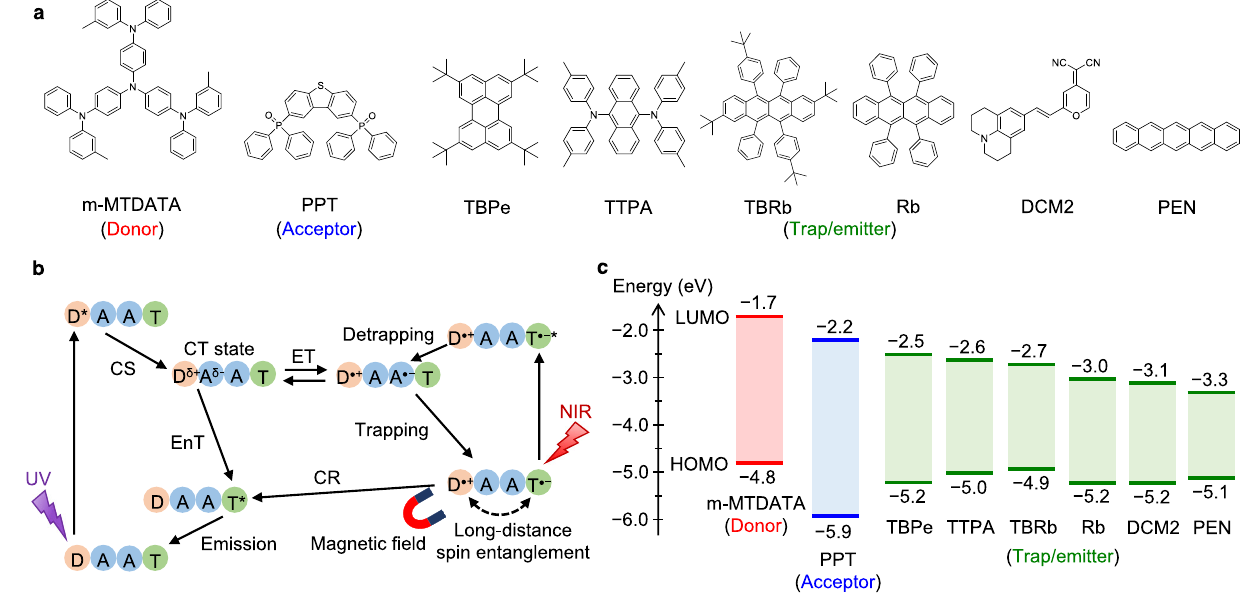
Fig. 1 Schematic illustration of organic PSL systems. a Molecular structures of m-MTDATA, PPT, and trap/emitter molecules. b Proposed reaction scheme of organic PSL. During UV excitation, an electron is transferred from the excited state of donor (D) to acceptor (A) to form the CT excited state or exciplex (D δ + A δ − ). The electrons in the fi lm diffuse between A molecules and are partly captured by trap/emitter (T) molecules, forming their radical anions (T • − ). The excited state of T • − (T • − *) formed by NIR stimulation causes electron transfer to A. The excited state of T (T*) is then formed via FRET from the regenerated CT state or superexchange charge recombination, resulting in visible PSL. The luminescence from T* is also modulated by external magnetic fi elds through long-distance spin entanglement between singlet and triplet states of the D • + ···T • − pair. EnT energy transfer, ET electron transfer, CS charge separation, and CR charge recombination. c Highest occupied molecular orbital (HOMO) and LUMO levels of m-MTDATA, PPT, and trap/ emitter PSL was observed for the m-MTDATA/PPT/Rb fi lm even at 77 K (Supplementary Figure 12). In the case of TBPe, the weak PSL may be due to inef fi cient excitation of radical anions since TBPe • − has very weak absorption bands in the NIR region 21 .